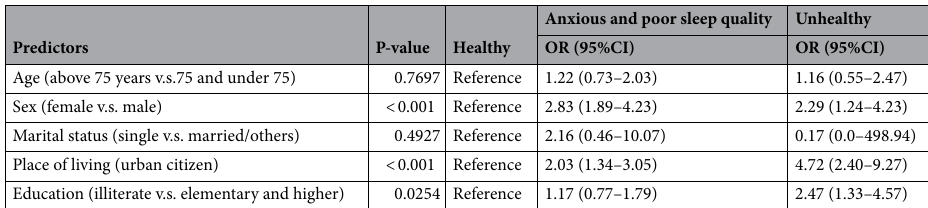
Table 5. Predictors of membership in latent classes of quality of life, sleep quality and common mental disorders among Iranian older adults.